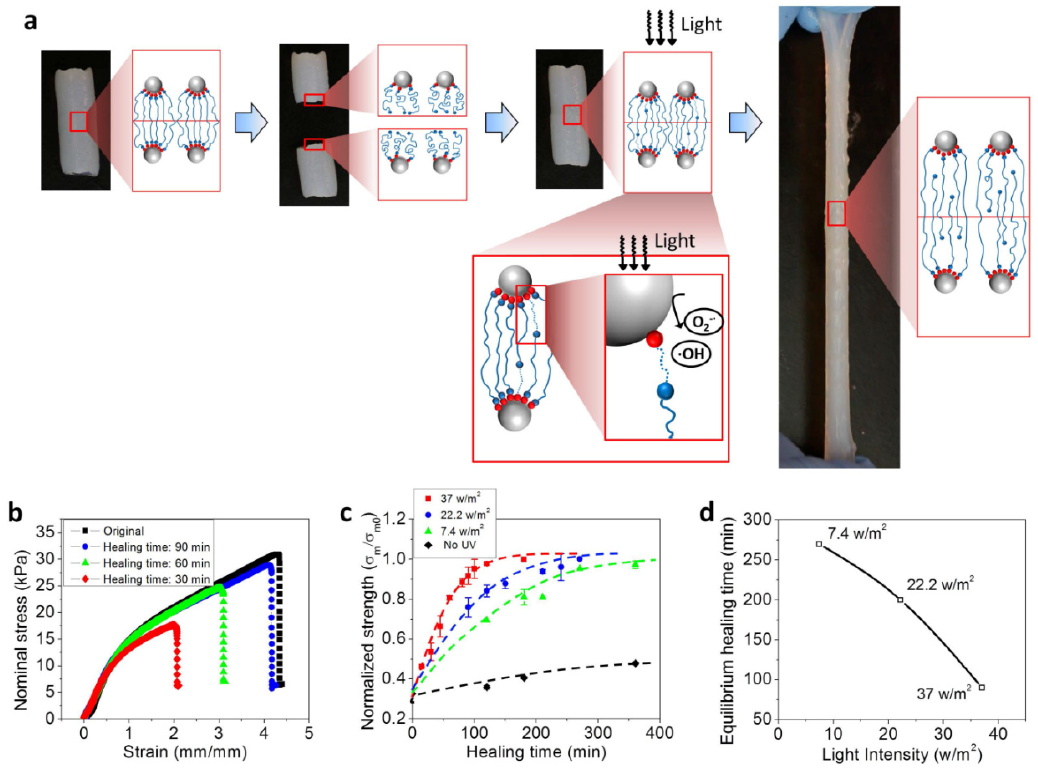
Figure 2. ( a ) Experimental images and polymer ‐ network schematics to show the self ‐ healing experiment. ( b ) Stress ‐ strain behaviors of the original TiO 2 hydrogel sample and self ‐ healed samples for various healing time. The nominal stress is defined as the tensile force over the original cross ‐ section area. ( c ) The normalized strength of TiO 2 hydrogel samples as functions of healing time under UV exposure with various light intensities. σ m and σ m 0 denote the strength of the self-healed sample and original samples, respectively. ( d ) Equilibrium healing time of TiO 2 hydrogel samples as a function of the light intensity. The equilibrium healing time is defined as the healing time corresponding to the normalized healing strength σ m / σ m 0 around 90%.